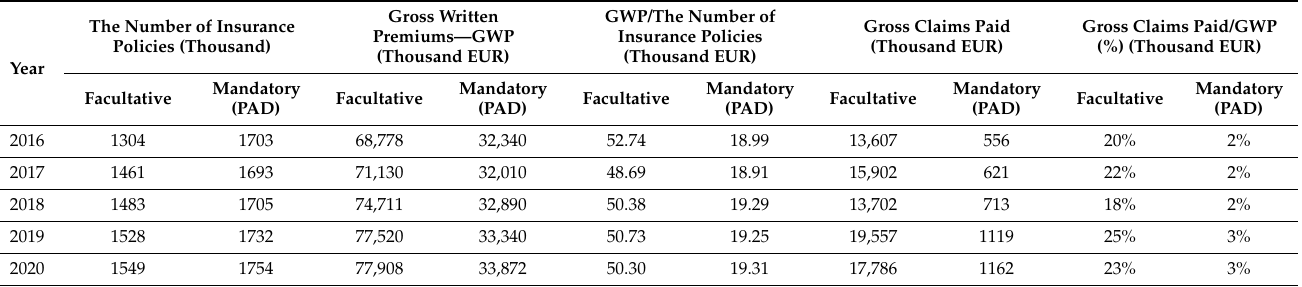
Table 1. The mandatory insurance scheme vs. the facultative insurance scheme for the home insurance market of Romania.